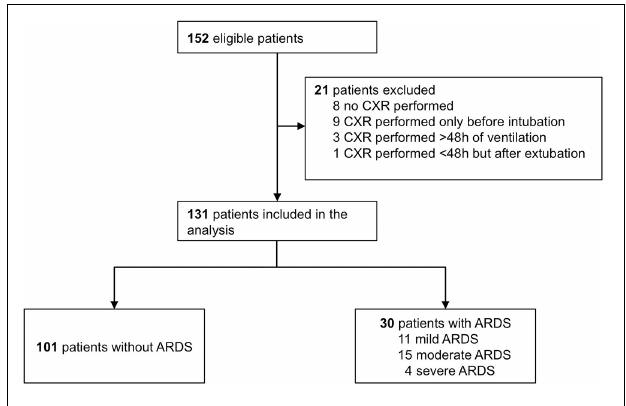
FIGURE 2 | Patient